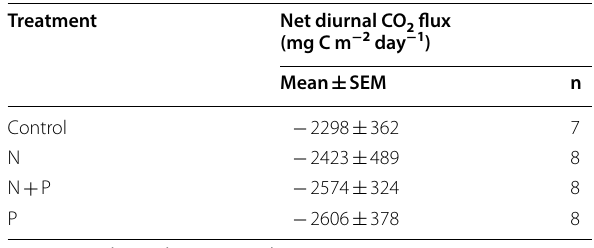
Negative numbers indicate net uptake CH 4 addition treatment was merged with its control, resulting in doubling of the